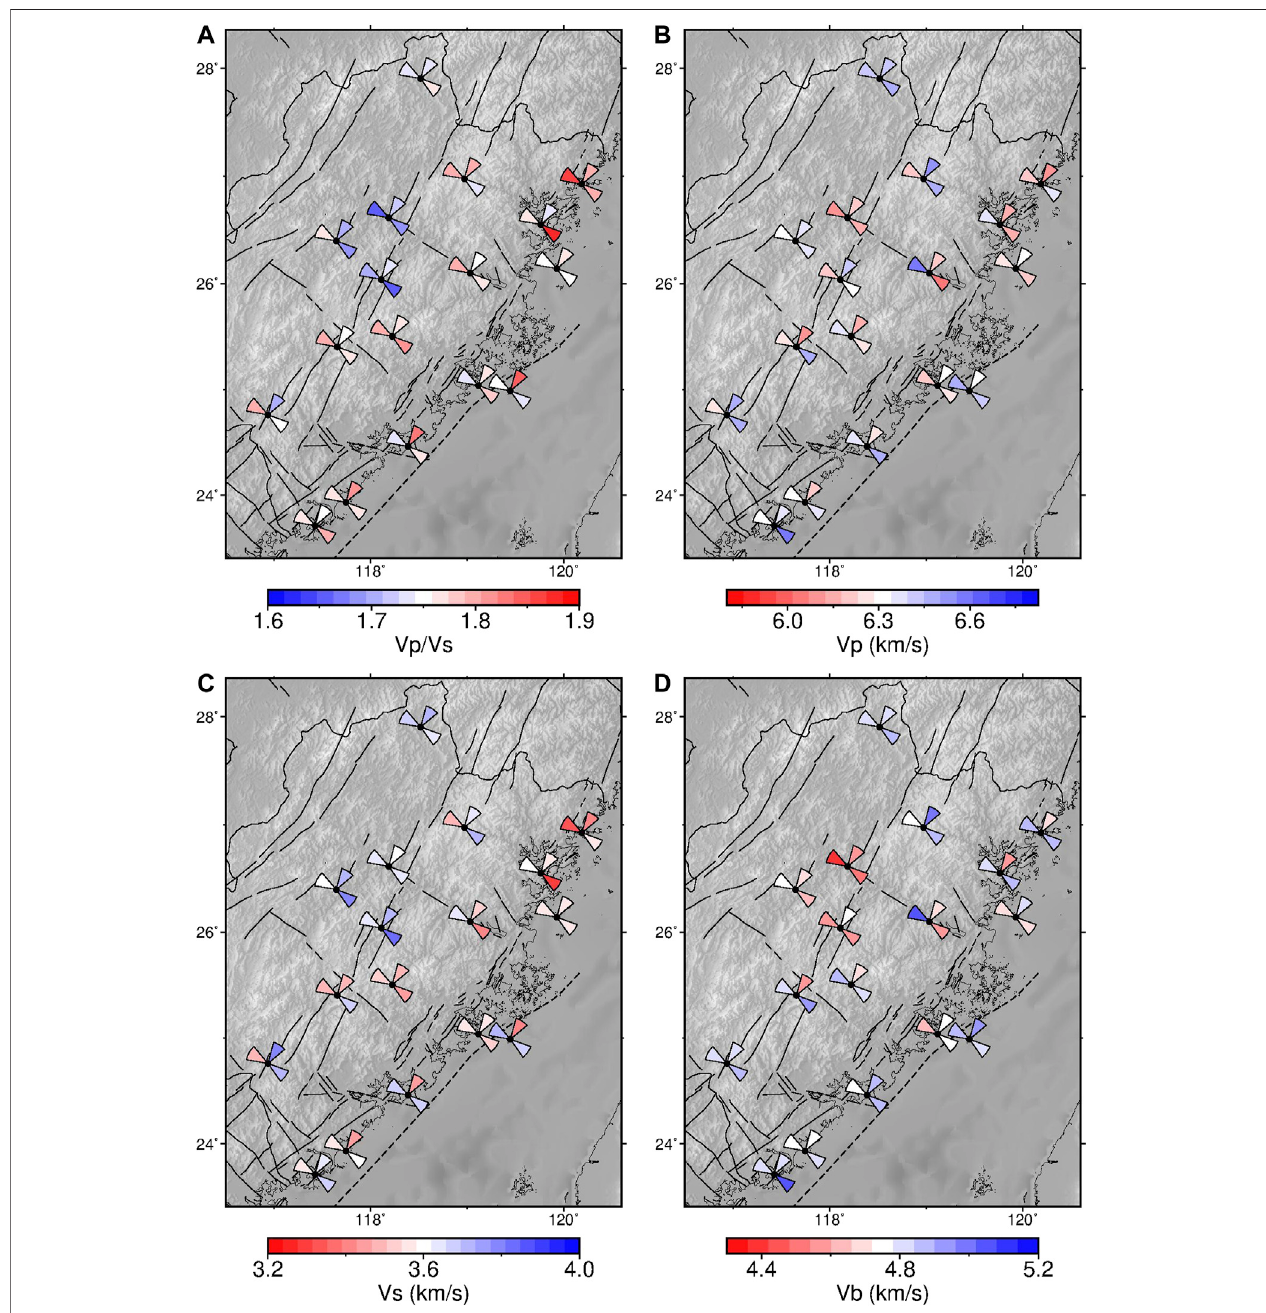
FIGURE 5 | Variation of average (A) Vp/Vs, (B) Vp, (C) Vs, and (D) Vb (bulk sound speed) of the crust between the stations observed in the three backazimuth sectors determined by the H-V stacking.